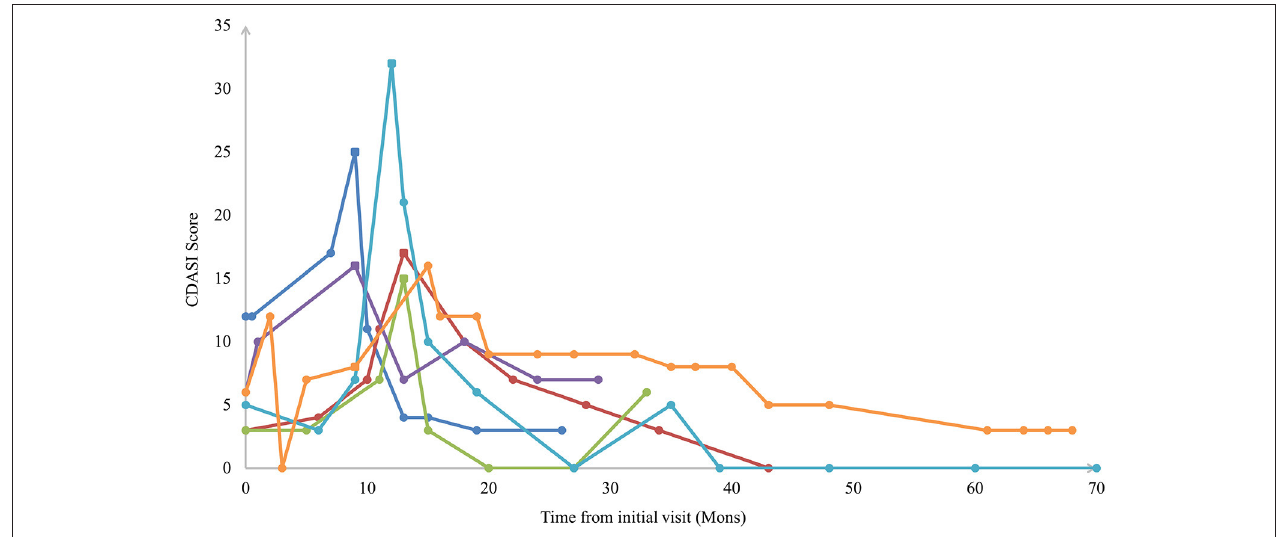
FIGURE 1 | Sample plots of Cutaneous Dermatomyositis Assessment and Disease Severity (CDASI) among patients with extended clinical amyopathic dermatomyositis vs. follow-up time. The square icon indicated the CDASI score at the time of developing clinical muscle